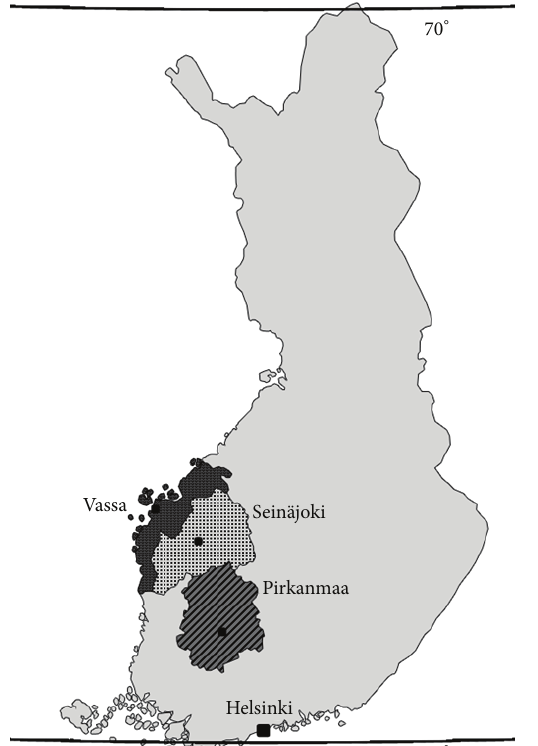
Figure 1: Map of Finland. Finland lies in Scandinavia, North Europe, between latitudes 60 and 70 ∘ N. Gulf of Bothnia in northern part of Baltic Sea limits the west coast. The total population was 5.4 million in 2010. Locations of Central Hospitals in Sein¨ajoki (dots) and Vaasa (dark grey) and University Hospital of Tampere at Pirkanmaa district (oblique lines) are pointed in the